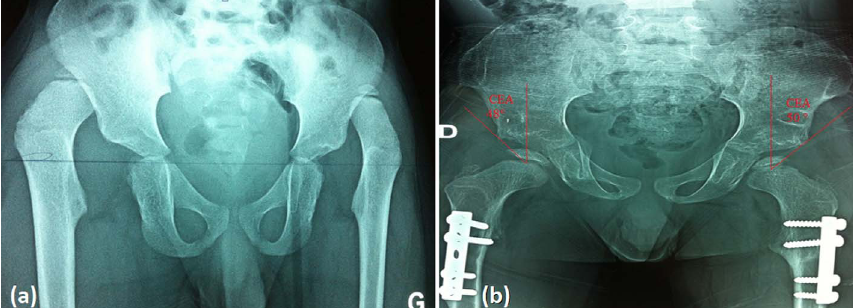
Figure 2. (a) Preoperative radiograph of a boy 5 years old of age with bilateral DDH; (b) radiograph at 4 years follow-up after open reduction